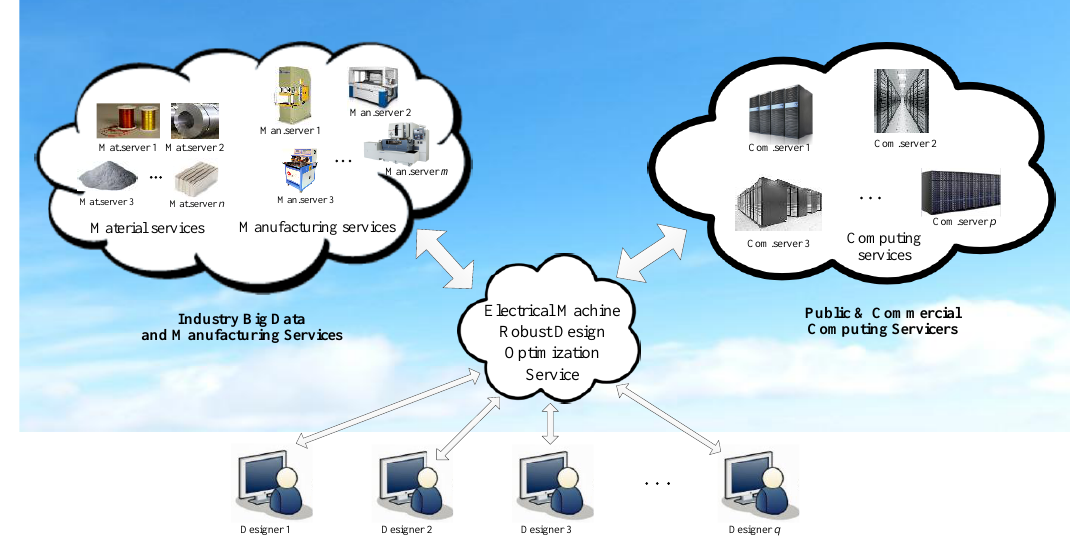
Figure 17. Proposed robust design optimization service for electrical machines.